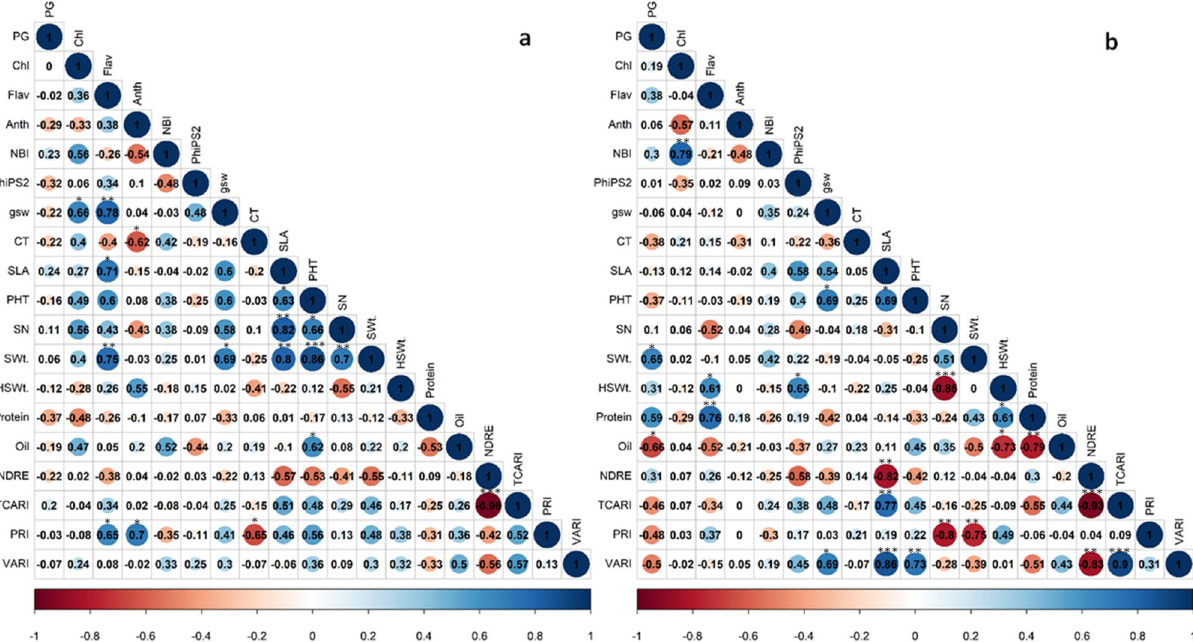
Figure 6. Pearson’s correlation coefficient between pigments, physiology, leaf reflectance properties, yield, and quality parameters under control (a) and drought stress (b) . The high and low intensity of color represents strong and weak relationships (blue for positive and red for negative) between the two variables, respectively. Values closer to one indicate a strong correlation, and a value closer to zero indicates a weaker relationship between the two variables. * p < 0.05, ** p < 0.01, *** p < 0.001 indicate significant correlation between pair of parameters. Traits acronyms are given in Table 1.